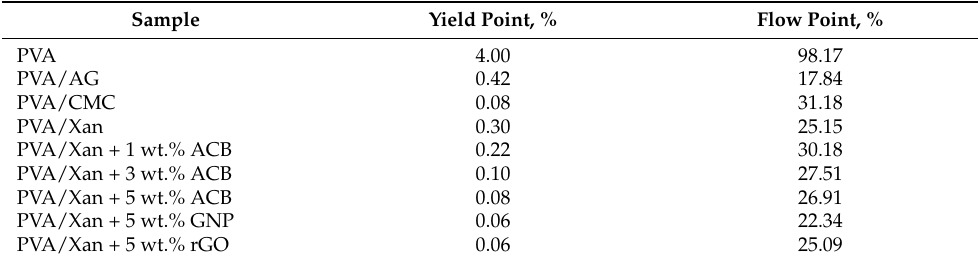
Table 2. Yield and flow point values from strain-dependent oscillatory shear rheology of the PVA based hydrogels at a fixed frequency (10